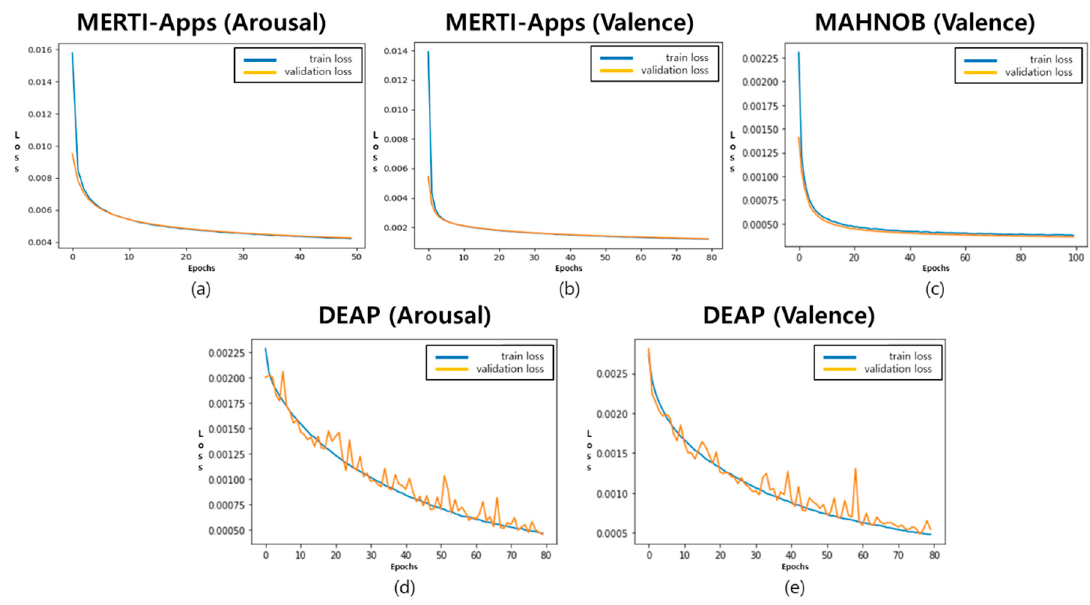
Figure 11. Training loss and validation loss of GA-LSTM Model using ( a ) MERT-Apps Arousal, ( b ) MERT-Apps Arousal, ( c ) MAHNOB, and ( d ) DEAP Arousal, ( e ) DEAP Valence datasets.